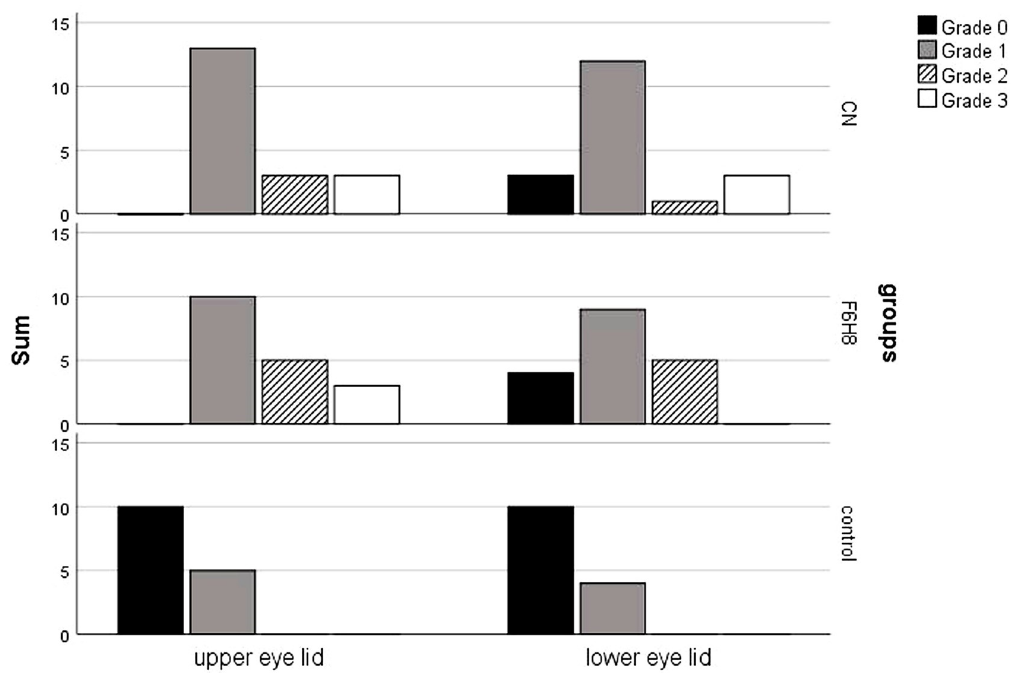
Fig 7. Meibomian gland scores of the upper and lower eyelid. Grade 0: No loss of Meibomian glands; Grade 1: Loss of Meibomian glands less than one third of the total density on the eyelid; Grade 2: Loss between one and two thirds of the total density of the glands on the eyelid; Grade 3: Loss of glands is greater than two-thirds of the total density of glands on the eyelid; MGD = Meibomian gland dysfunction; CN = cationic nanoemulsion; F6H8 = perfluorohexyloctane.